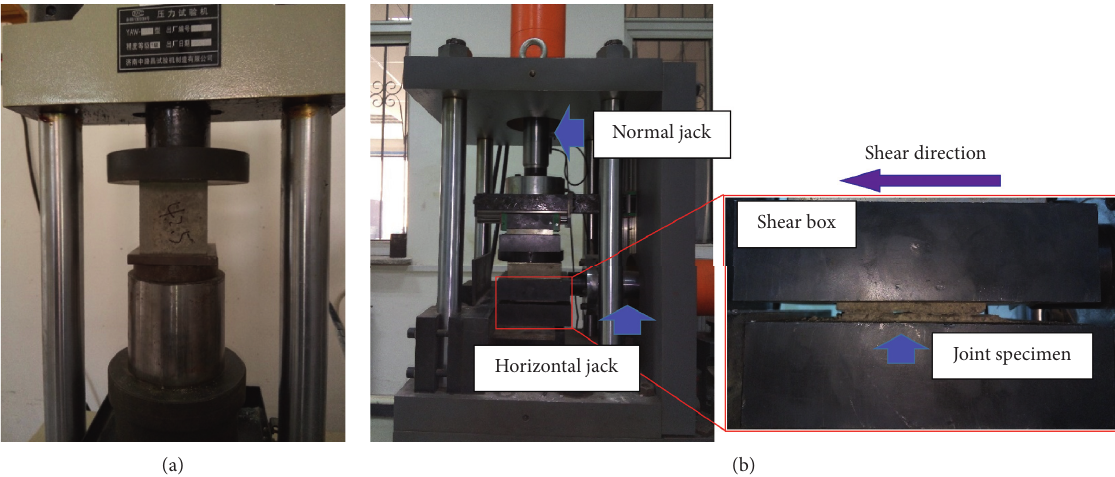
Figure 3: Uniaxial compression test and shear test of concrete material joint specimens: (a) Uniaxial compression test. (b) Shear test.